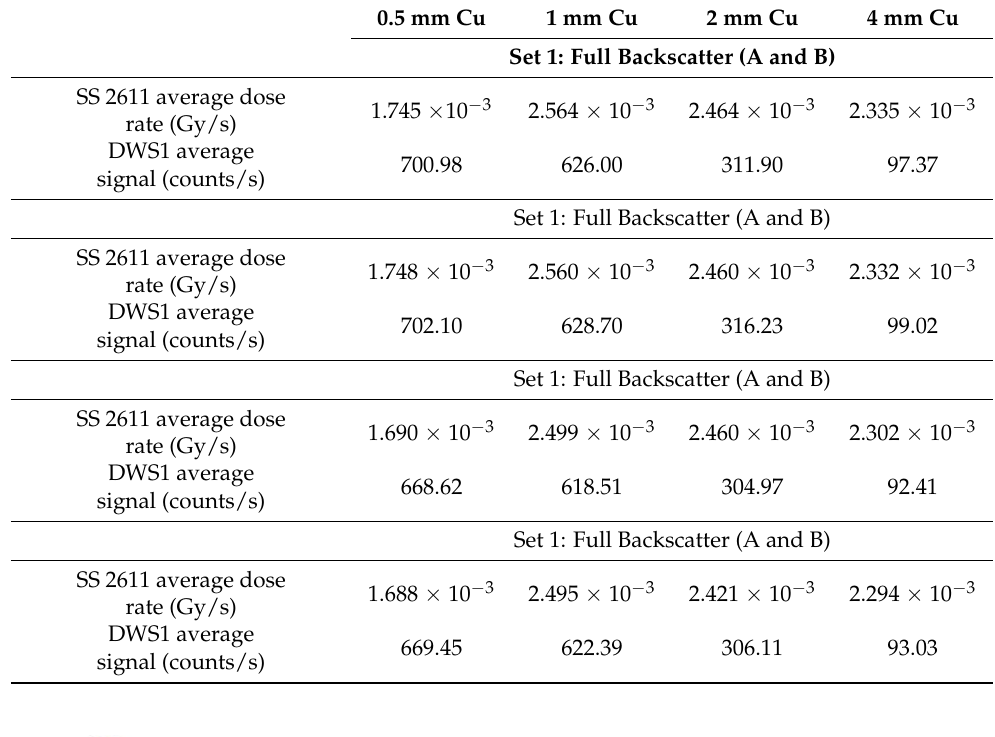
Table 3. Measurements recorded during the DWS1 cross-calibration at NPL 300 kV facility.